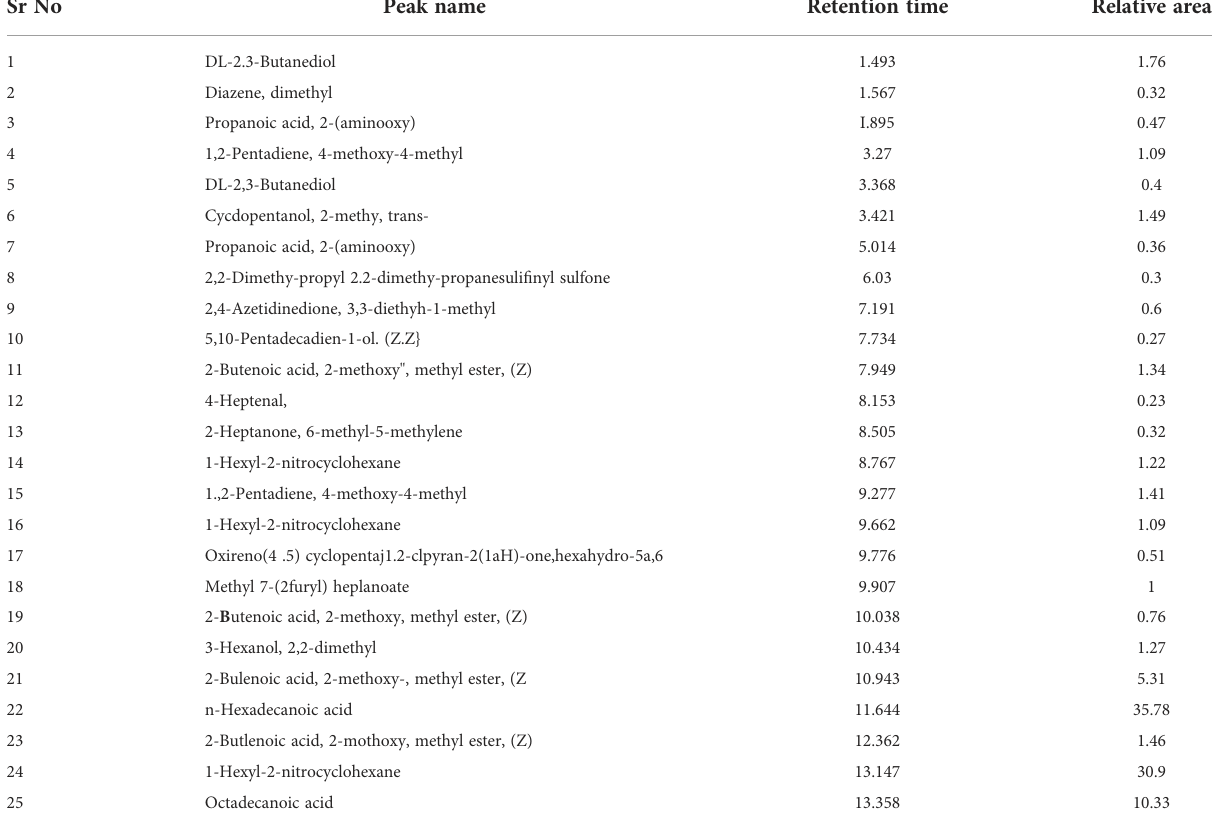
TABLE 2A Chemical compounds identity of Sargassum sp.